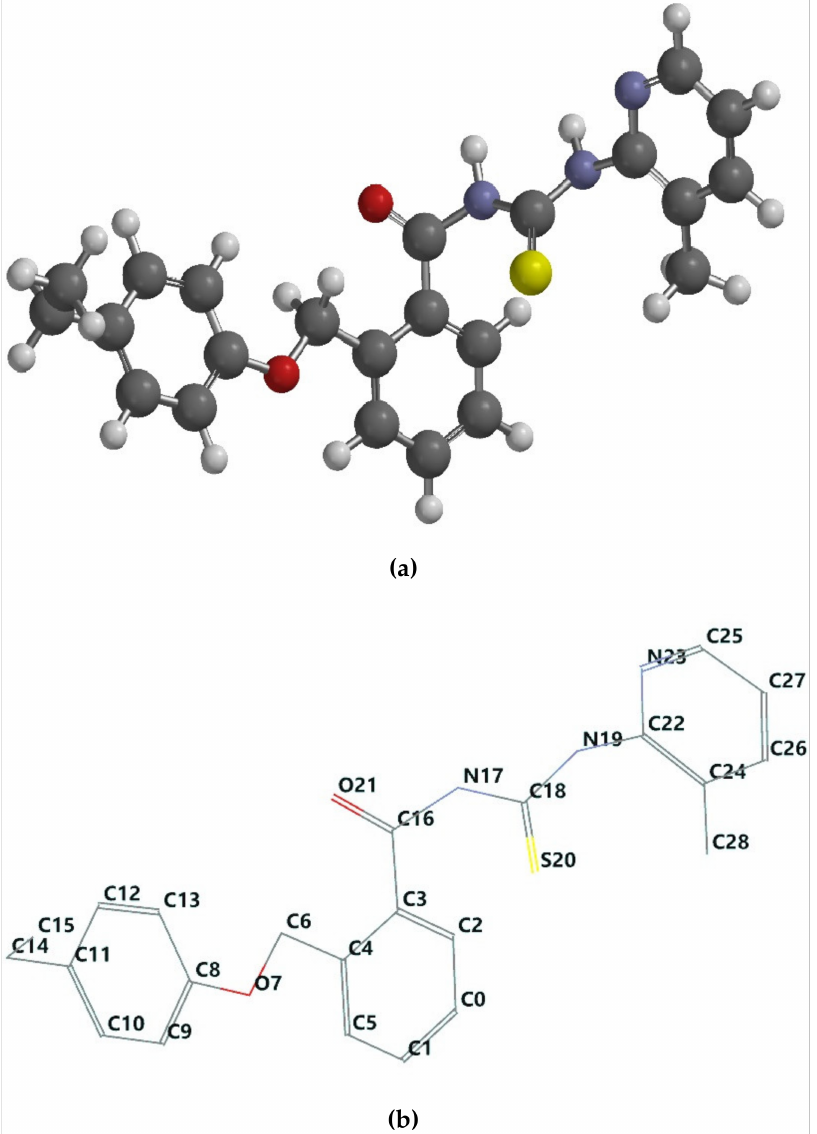
Figure 1. ( a ) The ball and spoke representation of the 1d molecular structure. ( b ) The wire label representation of the 1d optimized molecular structure. By convention, the numbering of the atoms was assigned in accordance with Spartan 14 software. Supporting information with respect to the tube and wire label representation for every chemical compound included in the current study is provided in the Supplementary Materials, Figures S1a–o and